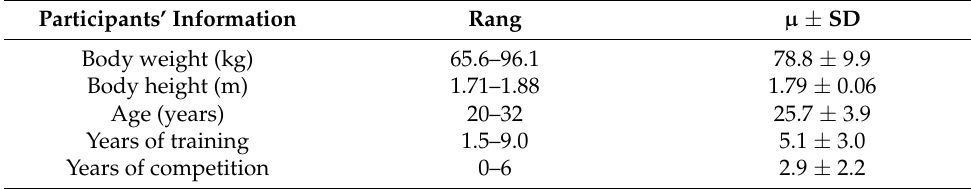
Table 1. Participants’